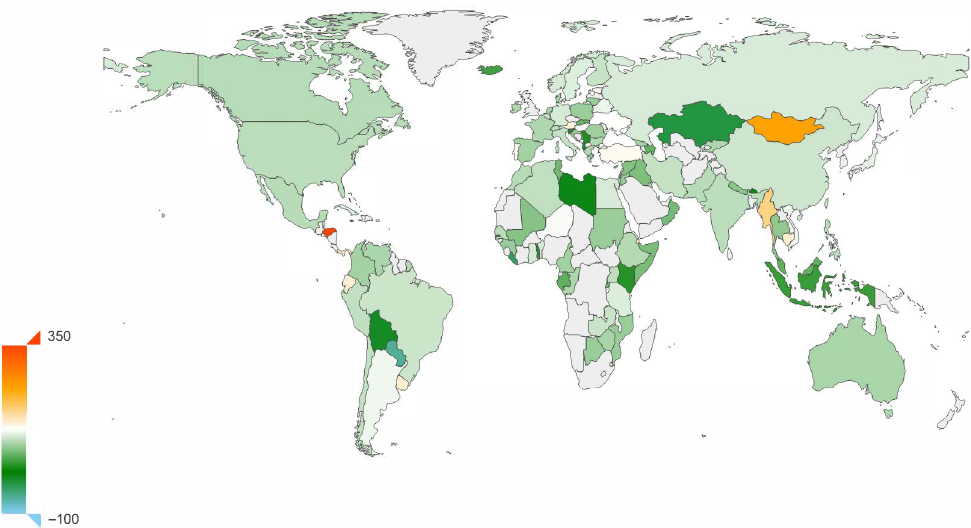
Figure 2. Sentiment polarity score. Average research sentiment polarity score of research, for different countries. Based on a sentiment analysis of abstracts of papers published on COVID-19. One- thousand times the real